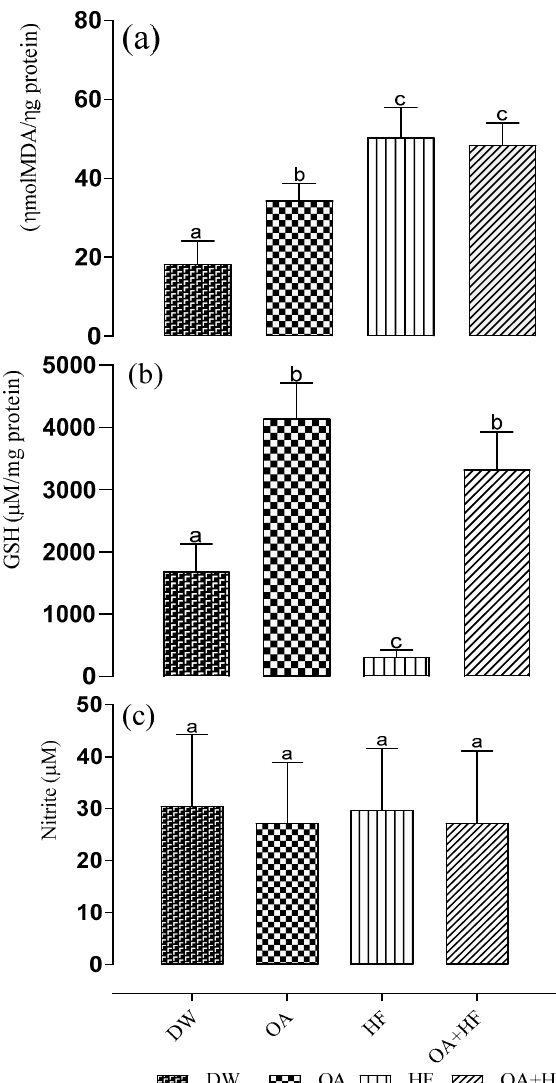
Figure 2. The effect of neonatal oral administration of oleanolic acid on the level of oxidative stress biomarkers in the skeletal muscles of suckling male and female pups ( a ) total glutathione (GSH) level ( b ) and nitrite concentration ( c ) in suckling male and female pups. Data presented as mean ± standard deviation. Bars having same alphabets indicate no significant differences while bars with different alphabets indicate significant differences at p < 0.05 across all groups. DW = gavaged daily with 10 mL/kg body mass of distilled water with 0.5% ( v/v ) dimethyl sulphoxide in the neonatal phase ( n = 8); OA = gavaged daily with 10 mL/kg body mass of oleanolic acid (60 mg/kg) in the neonatal phase ( n = 8); HF = gavaged daily with 10 mL/kg of 20% ( w/v ) fructose solution in the neonatal phase ( n = 7); OAHF = gavaged daily with 10 mL/kg body mass of oleanolic acid (60 mg/kg) and 20% ( w/v ) fructose solution in the neonatal period ( n = 6). Data in the same row with different superscripts is significantly different ( p < 0.05).